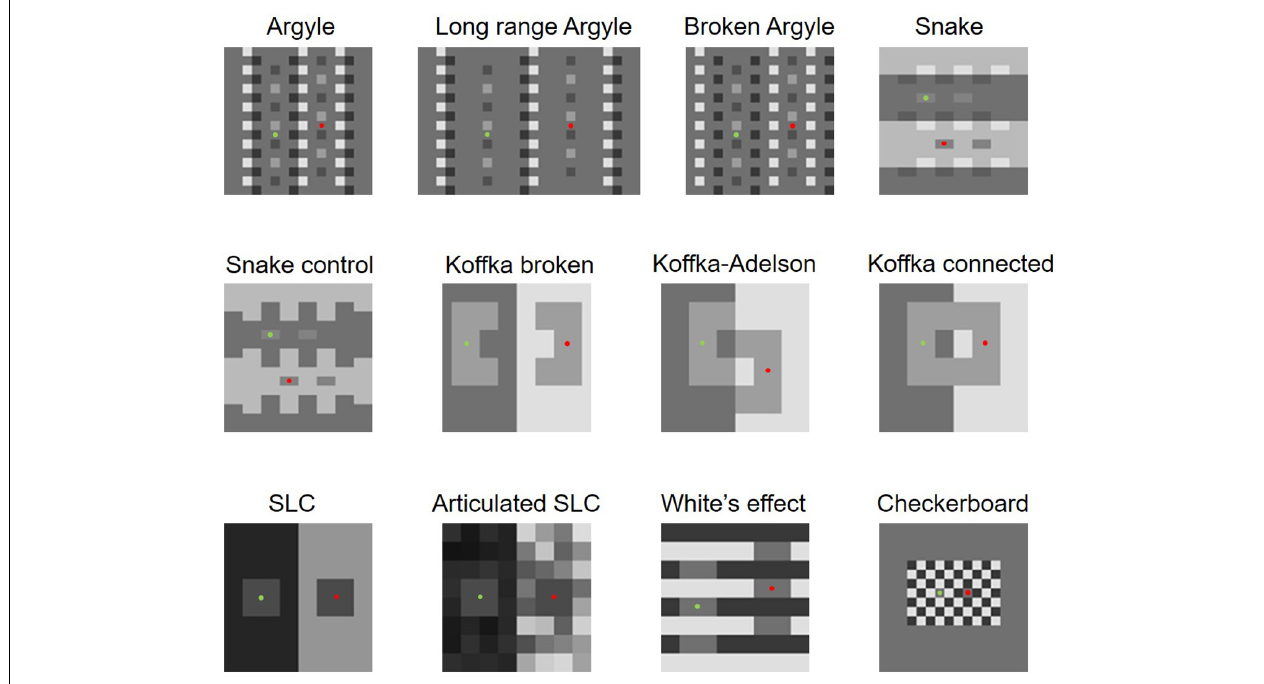
FIGURE 2 | Twelve stimuli used by Murray (2020). Green and red dots indicate the target